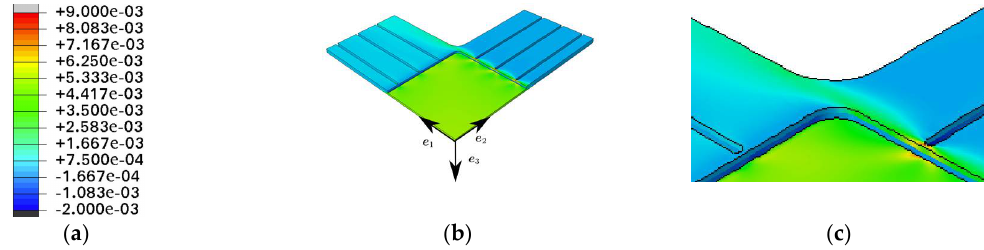
Figure 2. ( a ) Legend for strain ε in all following contour plots (without unit) ( b ) FE (finite element) results for uniaxial load in (cid:2187) (cid:2869) -direction at a displacement of the specimen arms of 0.2 mm, normal strain (cid:2013) (cid:2869)(cid:2869) ( c ) Detail from ( b ).